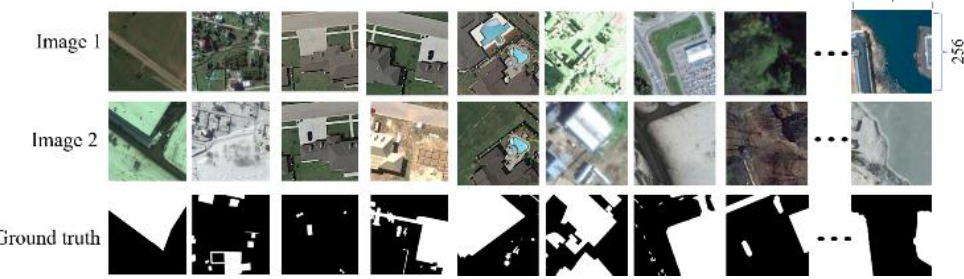
Figure 11. Samples of change detection dataset (CDD) image pairs.